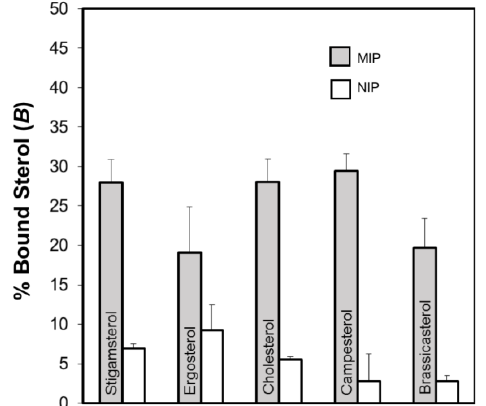
Figure 3. Static cross-reactivity binding evaluation based on single analyte binding studies with the semi-covalently imprinted stigmasterol MIP polymer P1 and the NIP polymer P3 with the sterols stigmasterol, ergosterol, cholesterol, campesterol, and brassicasterol. Binding conditions are described in the Materials and Methods. The error bars represent the standard error of the mean.